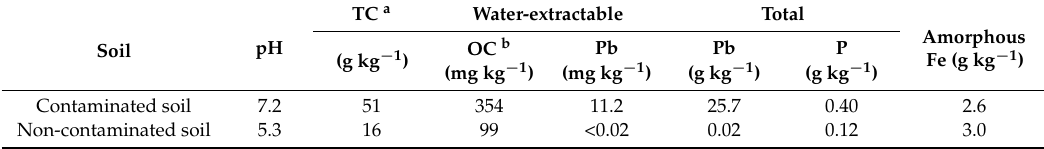
Table 1. Physicochemical properties of soils used in this study (on the basis of air-dried weight). TC Soil pH